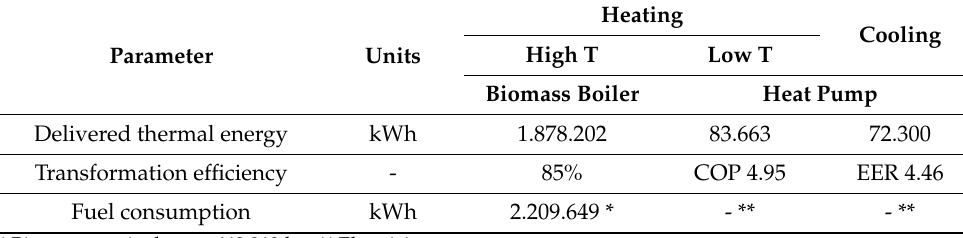
Table A1. Delivered thermal energy and total energy consumption for generation.